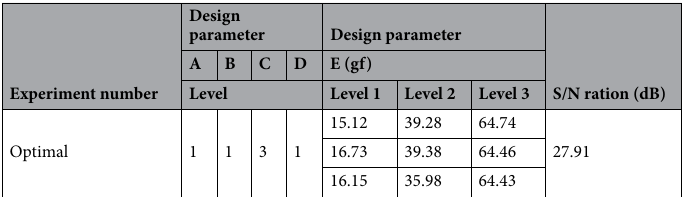
Table 3. Optimal design parameters by additional